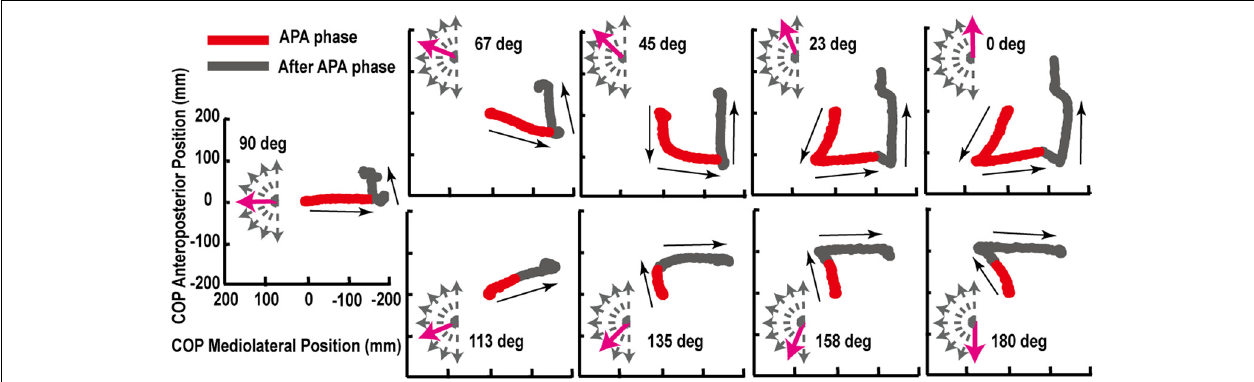
FIGURE 1 | Typical example of the center of pressure under feet (COP) trajectories for multidirectional step initiation tasks. The red lines show the COP trajectories during anticipatory postural adjustment (APA; red) phase or the phase from the lit-up of starting light-emitting diode (LED) to the take-off of the heel of the stepping foot. The gray lines show the trajectories from the end of the APA phase to the toe-off of the stance foot (after APA phase). The start of the COP anteroposterior and mediolateral position was set to zero.